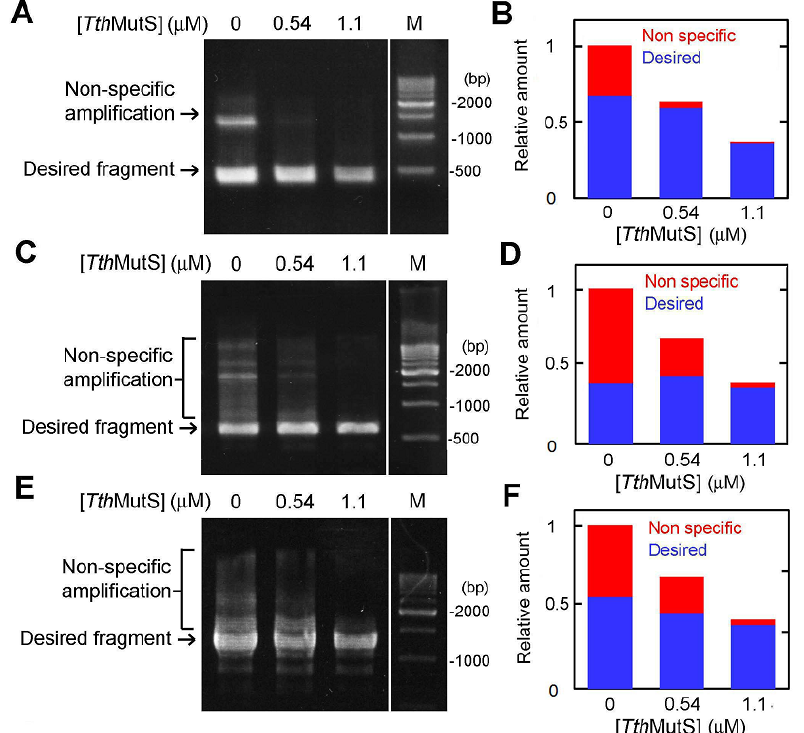
Figure 6. Effects of MutS on gene amplification from genomic DNA. ( A ) A 423-bp